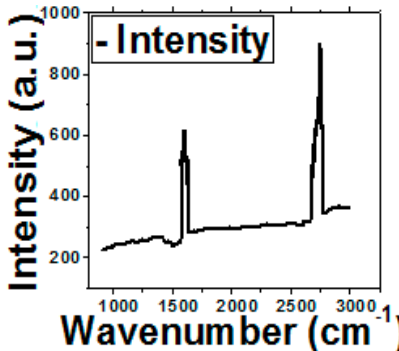
Figure 2. Raman Spectroscopy of graphene nanogrids.